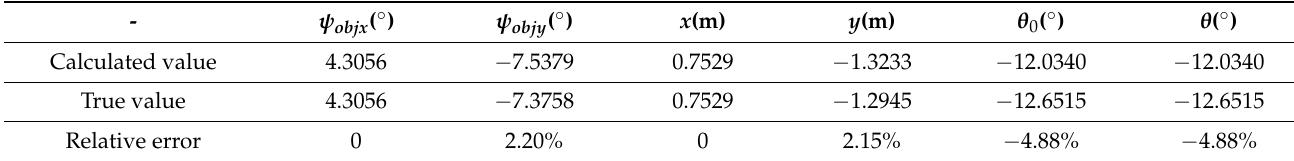
Figure 9. The original image was captured by the camera at P4 10 m above the DS and the extraction image of the LED light array. Table 2. Visually processed data (=10